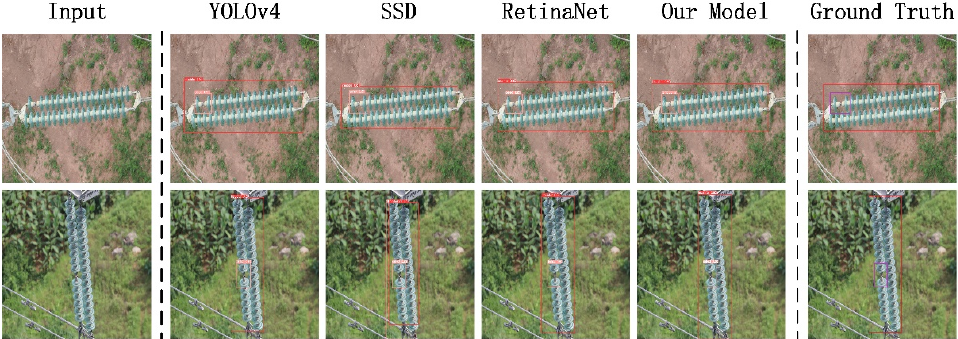
Figure 3. Test examples of one-stage class detectors on InsuDetSet, including our benchmark model YOLOv4, classic SSD and RetinaNet, and our model. The results show that our model outperforms other one-stage models.